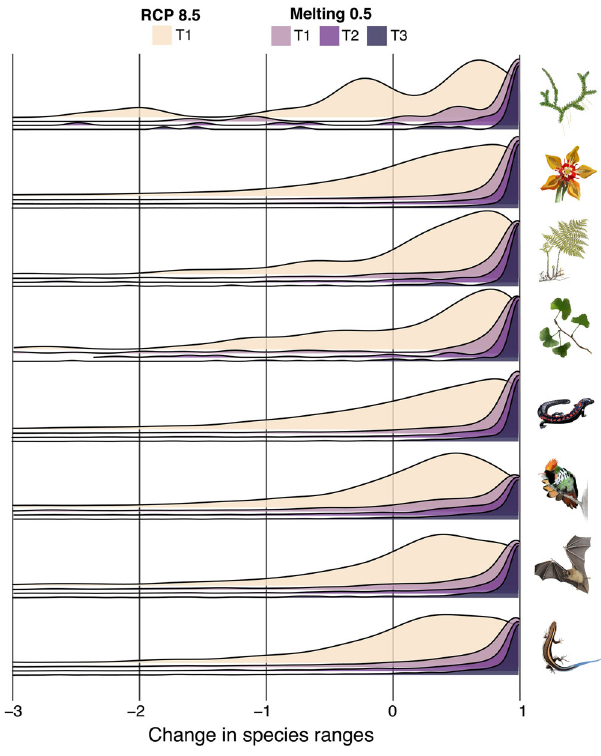
Fig. 3 Proportion of species of vascular plants and tetrapods with complete range loss across twelve megadiverse countries. The proportion of species (%) with complete range loss was estimated relative to the total number of species modeled for each group and country. The numbers below circles indicate the range of values estimated for 2030 across the four melting scenarios. Range size estimation was based on species distribution models and was standardized relative to the present-day species range size. Groups of species are indicated by the inset illustration (from left to right): amphibians, birds, mammals, reptiles, lycophytes, fl owering plants, ferns, and gymnosperms. Please fi nd time horizons T2: 2050 and T3: 2070, in the Supplementary Material.